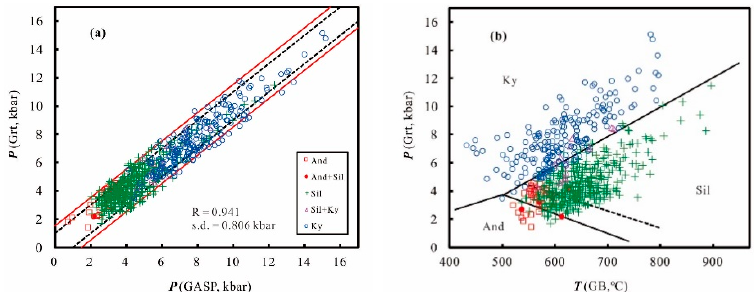
Figure 2. Performance of the present garnet geobarometer applied to the calibrant samples (Table S1). ( a ) Pressures determined by the present garnet geobarometer versus those by the GASP geobarometer [49]. The dashed black and solid red lines define ± 1.0 kbar and ± 1.5 kbar deviations, respectively; and ( b ) in combination with the garnet-biotite geothermometer [55], the present garnet geobarometer plotted 93.7% of the calibrant samples into the correct Al 2 SiO 5 -stability field. R, multiple correlation coefficient; s.d., standard error. Al 2 SiO 5 phase diagram: the sold lines are from [65], whereas the dashed line is from [66].